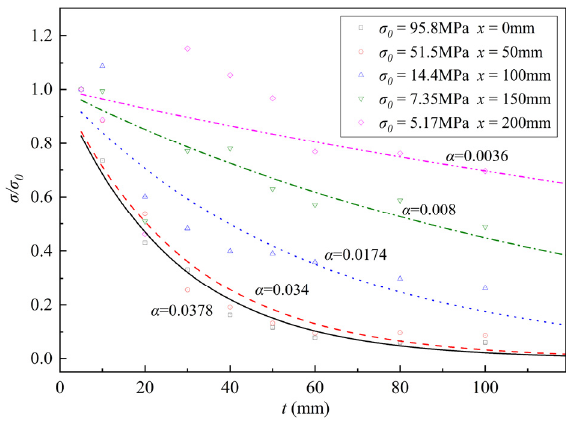
Figure 14. Stress attenuation of foamed concrete at different loading